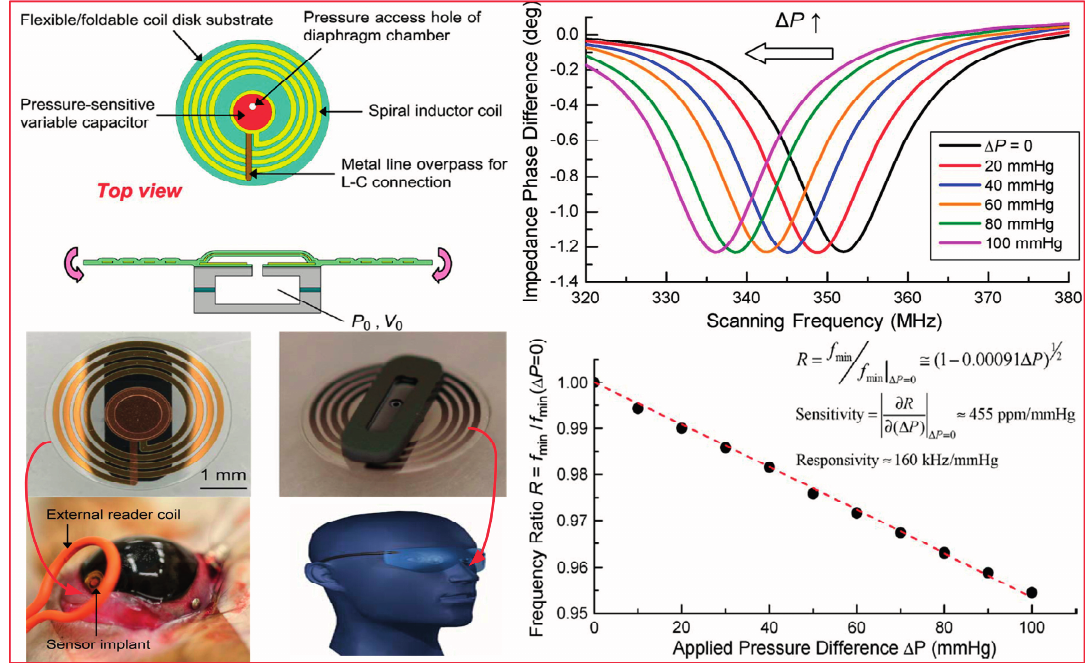
Figure 5. Implantable wireless passive LC pressure sensor for biomedical applications together with the experimental